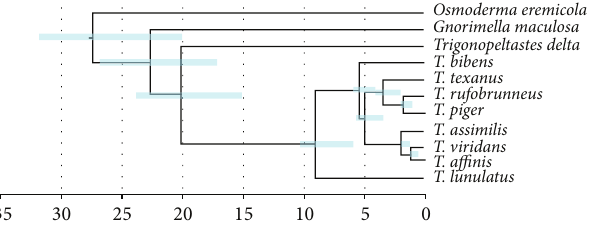
Figure 5: Tree showing divergence via the molecular clock. Dates are millions of years earlier and include the probable minimum and maximum age of